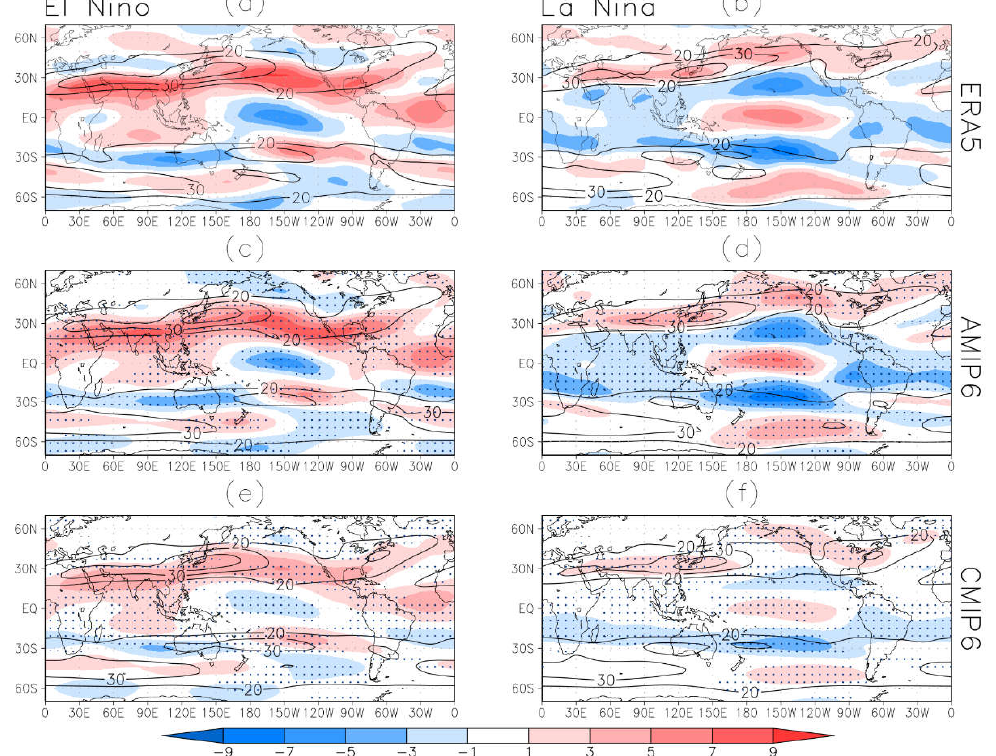
Figure 3. The 250 hPa zonal wind anomaly (shaded) for ( a , b ) ERA5 and the multi-model ensemble means of ( c , d ) AMIP6 and ( e , f ) CMIP6 during ( a , c , e ) El Niño and ( b , d , f ) La Niña years. Mean values are shown in contours, unit is m s − 1 . Stippling indicates where the anomaly of all models has the same